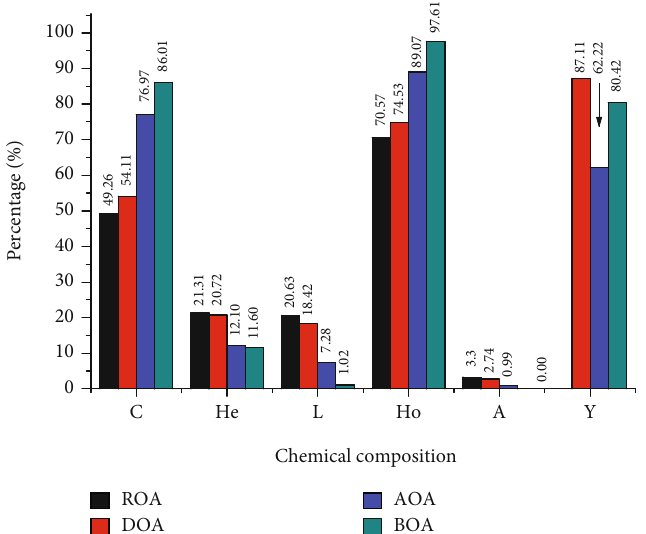
Figure 3: Chemical composition of Oxytenanthera abyssinica at di ff erent pretreatments. C: cellulose; He: hemicellulose; L: lignin; Ho: holocellulose; A: ash; Y: yield.